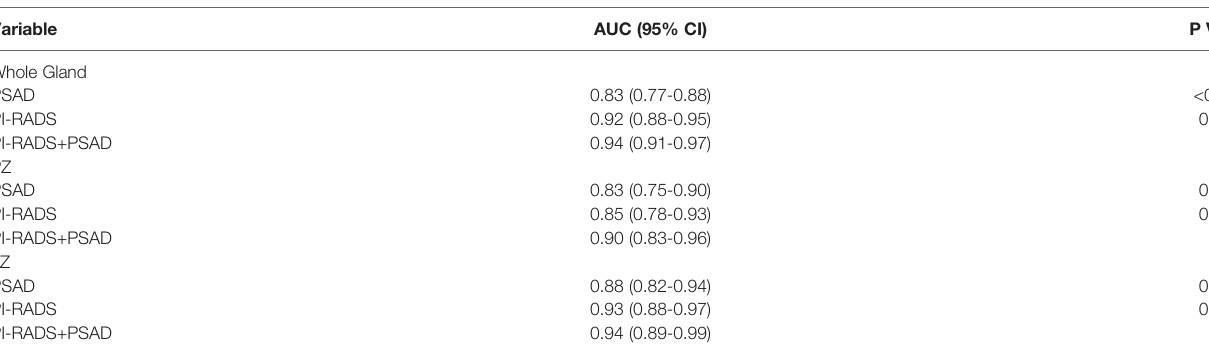
FIGURE 2 | ROC for the comparison of PI-RADS+PSAD with PI-RADS and PSAD alone for the diagnosis of the prostate cancer. PI-RADS, Prostate Imaging Reporting and Data System version 2.1; PSAD, prostate-speci fi c antigen density; AUC, area under the ROC curve. TABLE 4 | ROC curve analysis for predicting prostate cancer.